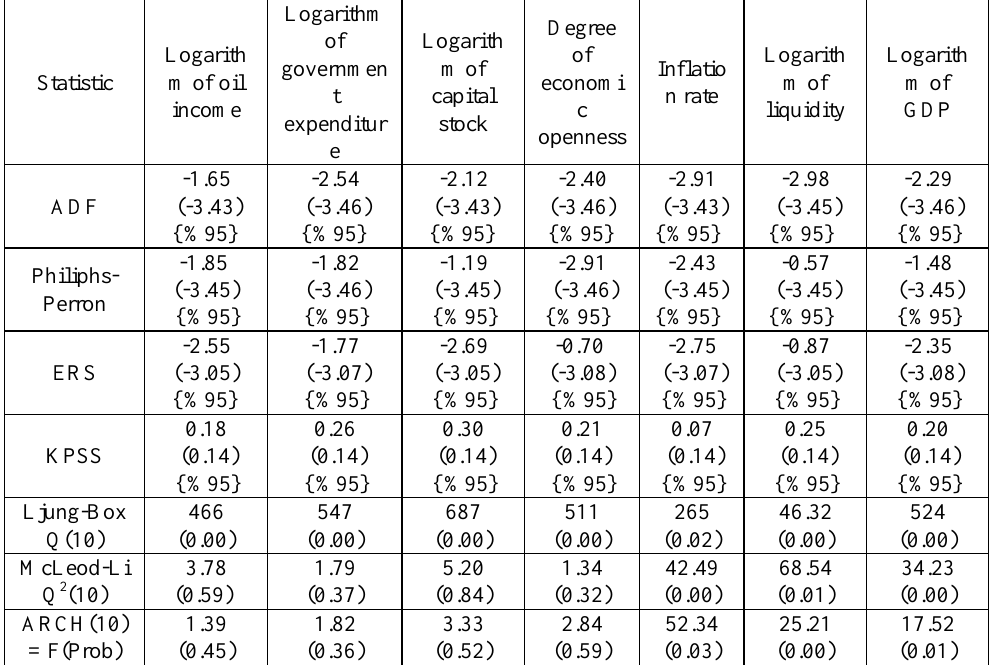
Table 1. Results of unit root, auto-correlation and heteroskedasticity tests